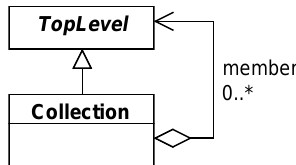
Figure 19: Diagram of the Collection class and its associated